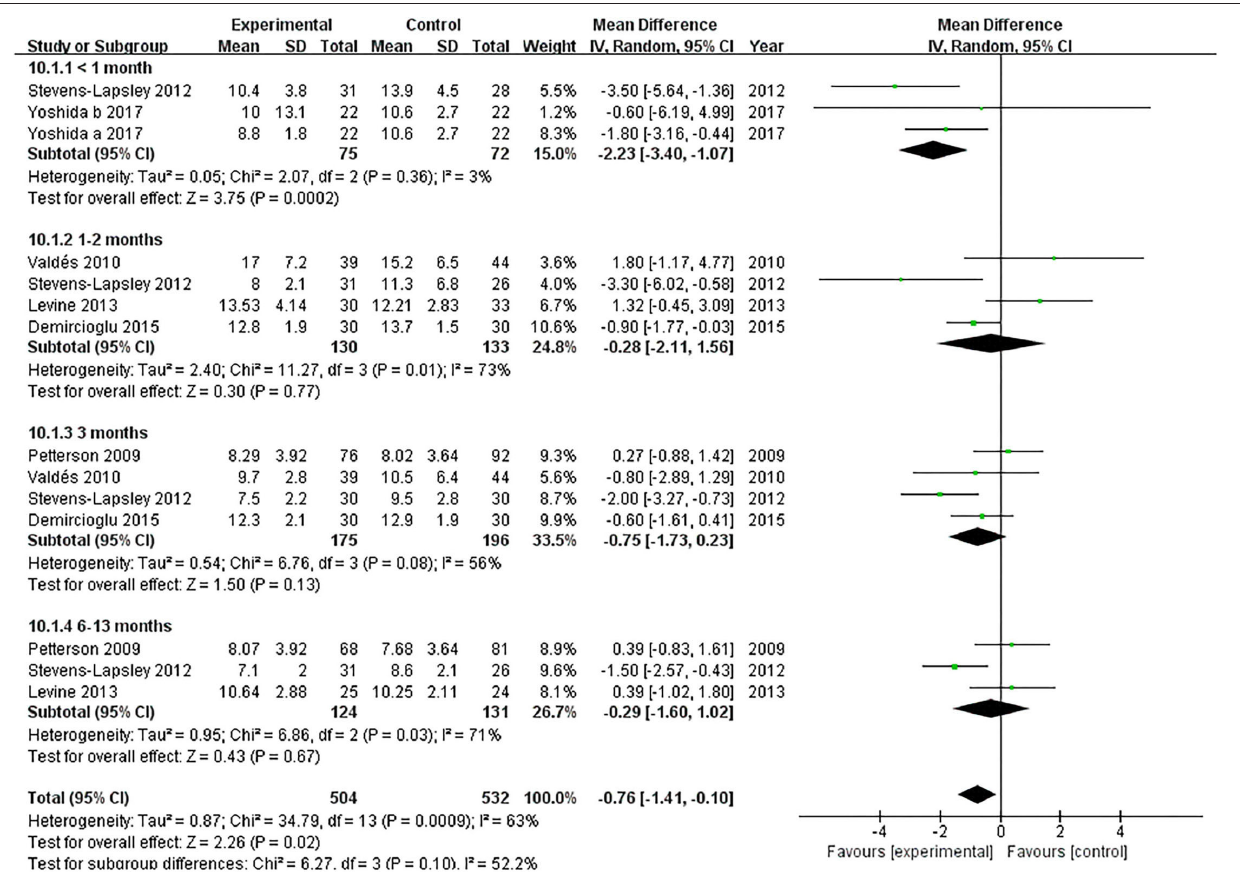
FIGURE 8 | Forest plots of meta-analysis of the effect of NMES vs. conventional rehabilitation on the timed up and go test.